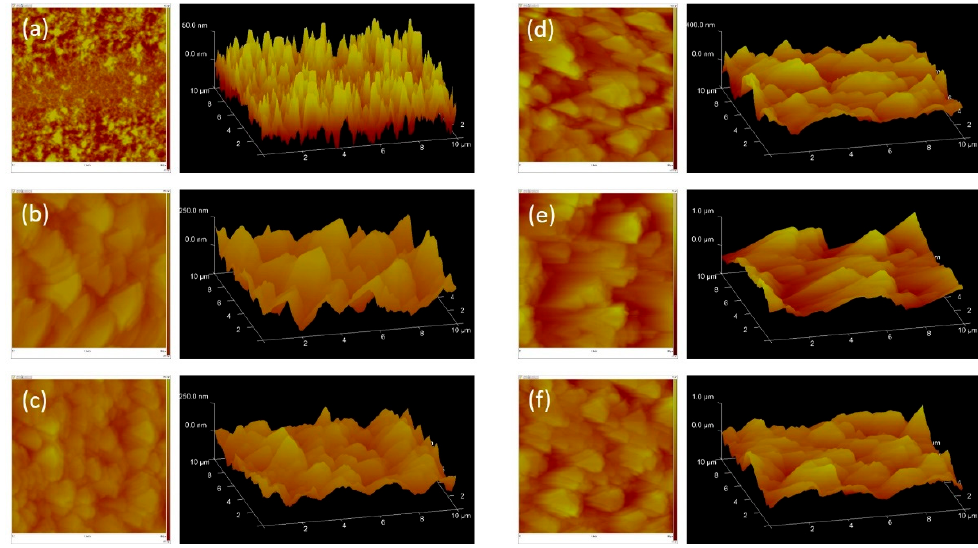
Figure 1. AFM topographic (left) and 3D (right) images of ( a ) poly(C 4 -EDOT-COOH); ( b ) poly(C 5 -EDOT-COOH); ( c ) poly(C 7 -EDOT-COOH); ( d ) poly(C 9 -EDOT-COOH); ( e ) poly(C 14 -EDOT-COOH); ( f ) poly(C 16 -EDOT-COOH). The scan size is 10 µm × 10 µm.